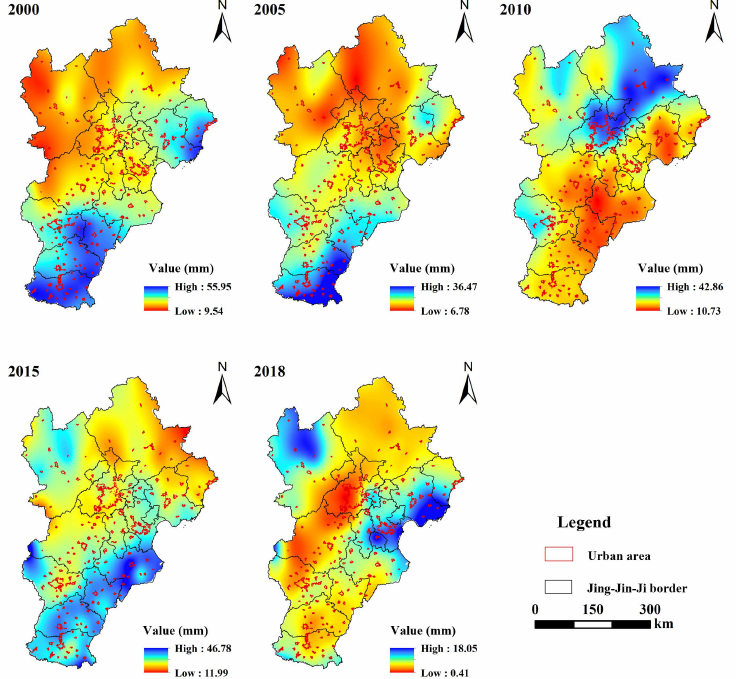
Figure 3. Spatial distribution of winter precipitation in different periods in the Beijing–Tianjin– Hebei